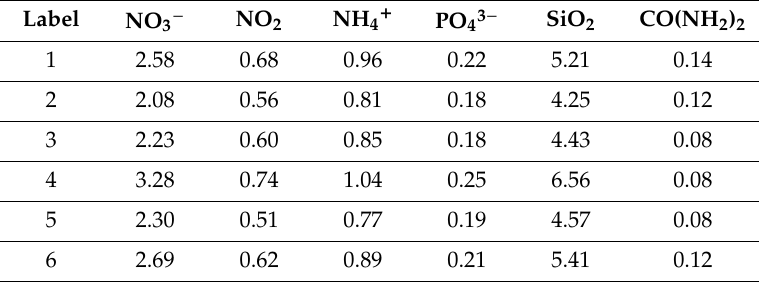
Table 1. Background nutrient concentrations ( µ mol · L − 1 ) in the seawater used in Experiments 1 and 2. Label